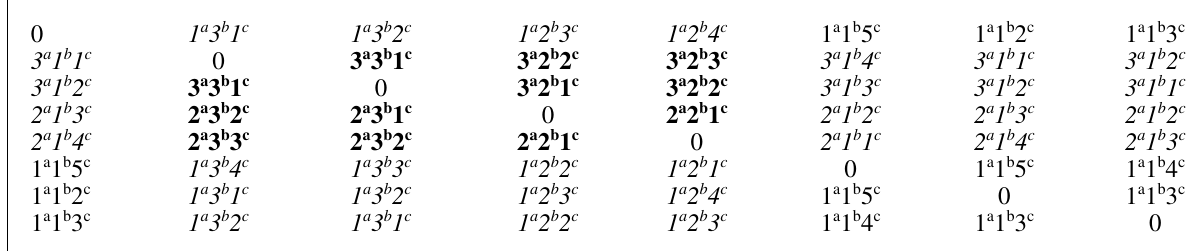
Figure 1. Universal matrix 14 U (a,b,c) ( Dval matrix 9,10 ) of 2,3-dimethylhexane. Bold : Members of index AB Normal script: Members of index D